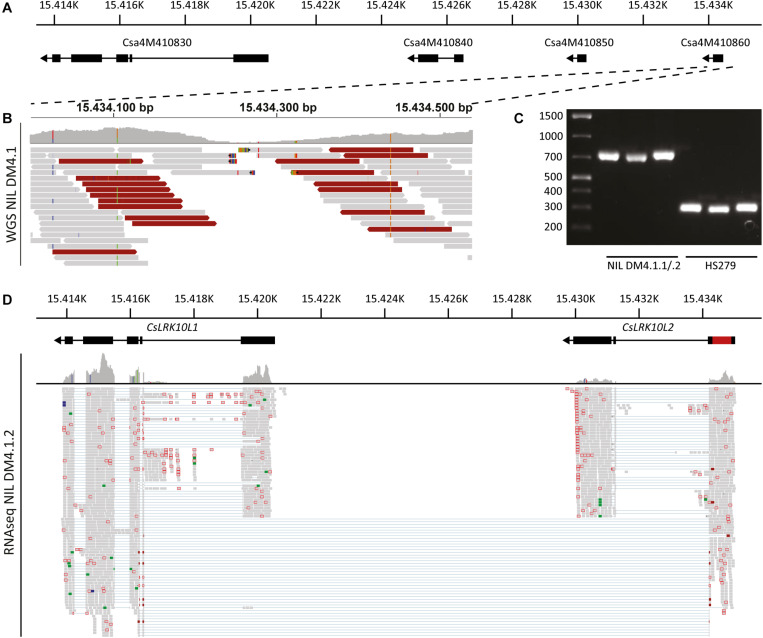
Genomic analysis of the RLK cluster DM4.1.2, indicating structural variation. (A) Predicted gene models of genes in the RLK cluster within the interval of subQTL DM4.1.2. Black boxes indicate predicted exons and lines represent predicted introns. Arrowheads indicate the orientation of the reading frame. Physical locations on chromosome 4 of the cucumber reference genome (Chinese Long 9930 v2) are indicated. (B) Whole genome sequencing reads of NIL DM4.1 aligning to predicted gene Csa4M410860 are visualized using the Integrative Genomics Viewer (IGV). A coverage graph is given above the aligned reads. Reads pairs with larger than expected or smaller than expected insert sizes are indicated in dark red and dark blue, respectively. (C) PCR was performed using primers designed to amplify the predicted gene Csa4M410860 on DNA samples isolated from the partially resistant NIL DM4.1.1/.2 and the susceptible recurrent parent HS279. (D) RNAseq reads from P. cubensis inoculated NIL DM4.1.1/.2 were re-aligned to the RLK cluster including the 551 bp insertion found in the predicted gene Csa4M410860. Gene models of CsLRK10L1 (Csa4M410830) and CsLRK10L2 (novel gene consisting of both Csa4M410850 and Csa4M410860) are indicated above, including the 551 bp insertion in red. Numbers indicate physical location on chromosome 4 of the cucumber reference genome (Chinese Long 9930 v2).